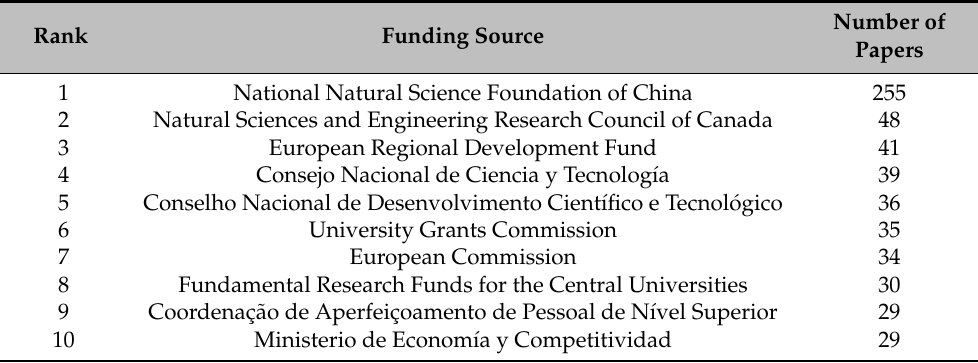
Table 5. Top 10 funding sources for laccase–assisted wastewater treatment studies.